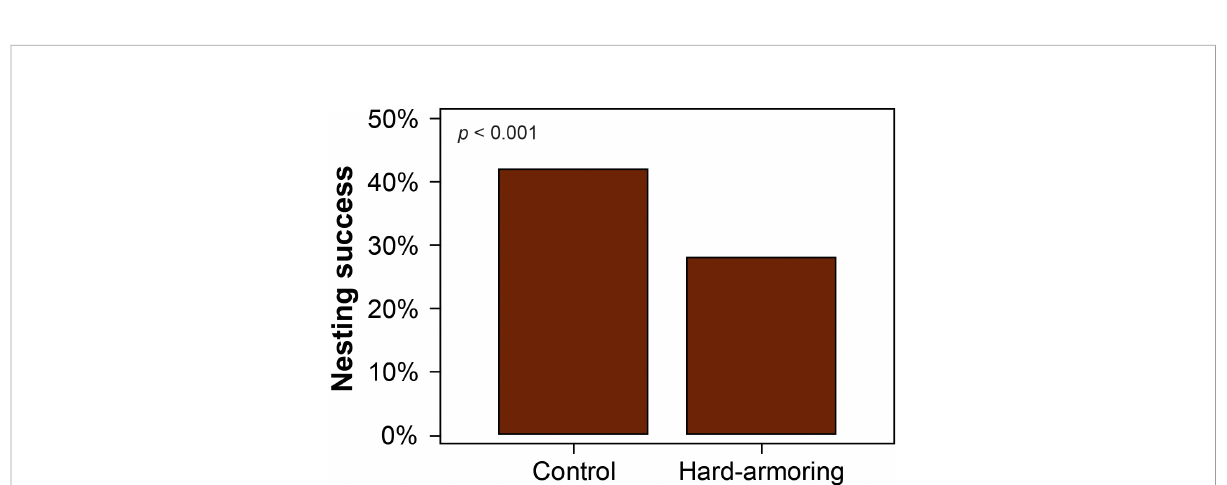
FIGURE 4 Nesting success was signi fi cantly lower at the hard-armoring structures in comparison to the control site for nesting loggerhead sea turtles ( Caretta caretta ) on Tequesta and Jupiter Inlet Colony Beaches, Florida,